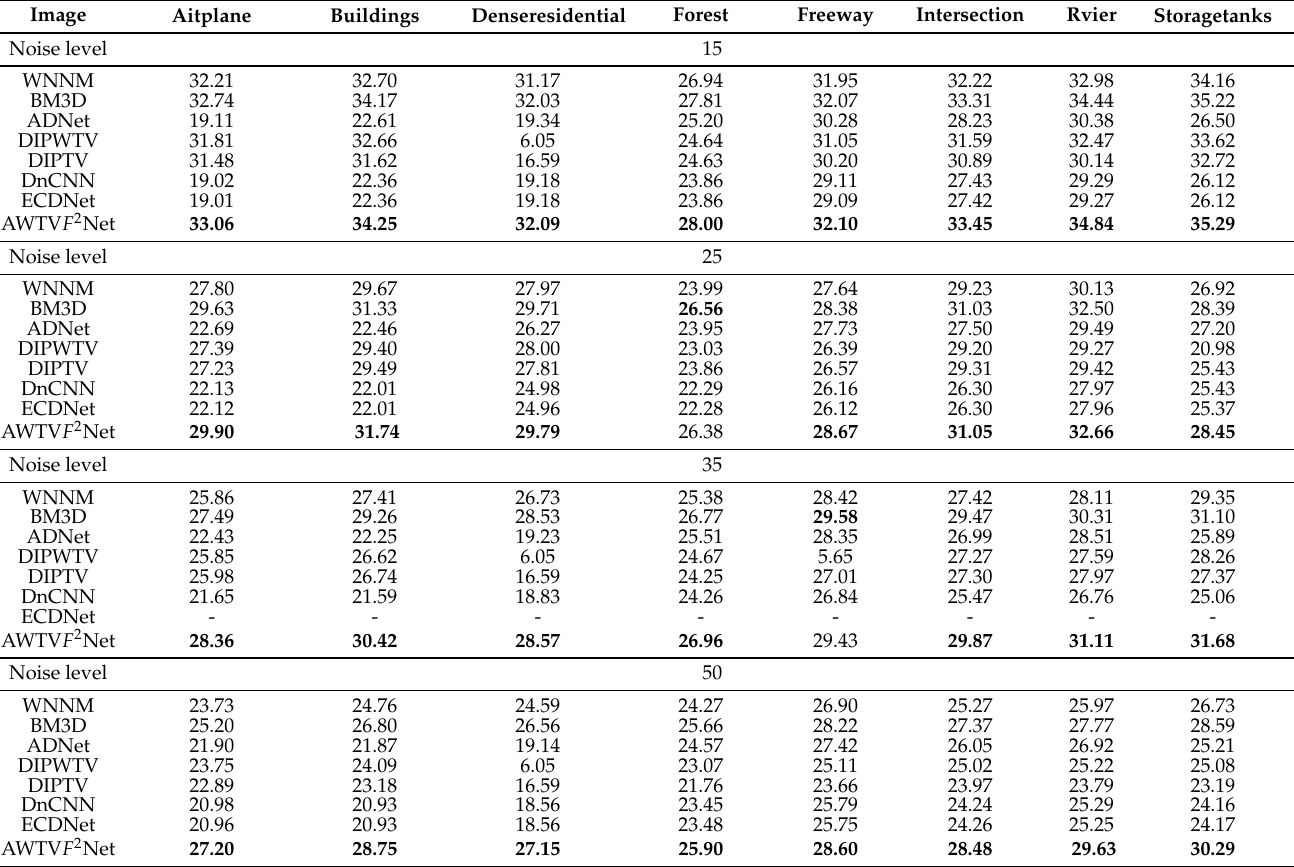
Figure 14. Detailed comparisons of the ‘Dense residential’ image with σ = 50. Table 4. Comparison results of different methods on UCL dataset. The bold values denote the best